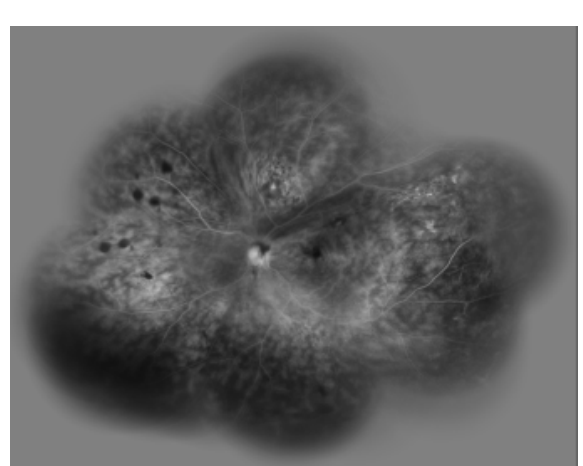
Figure 4: Fluorescein angiogram showed optic disc leakage and diffuse perivascular